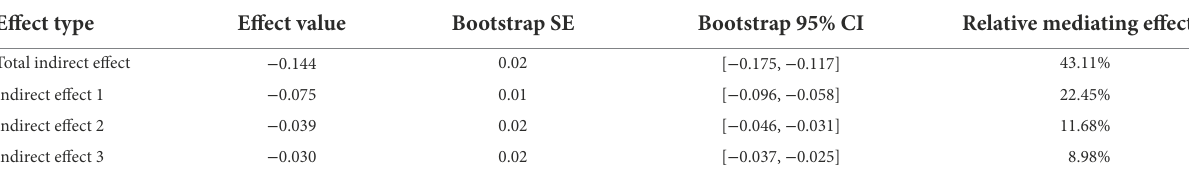
TABLE 2 Bootstrap indirect effect test( N =